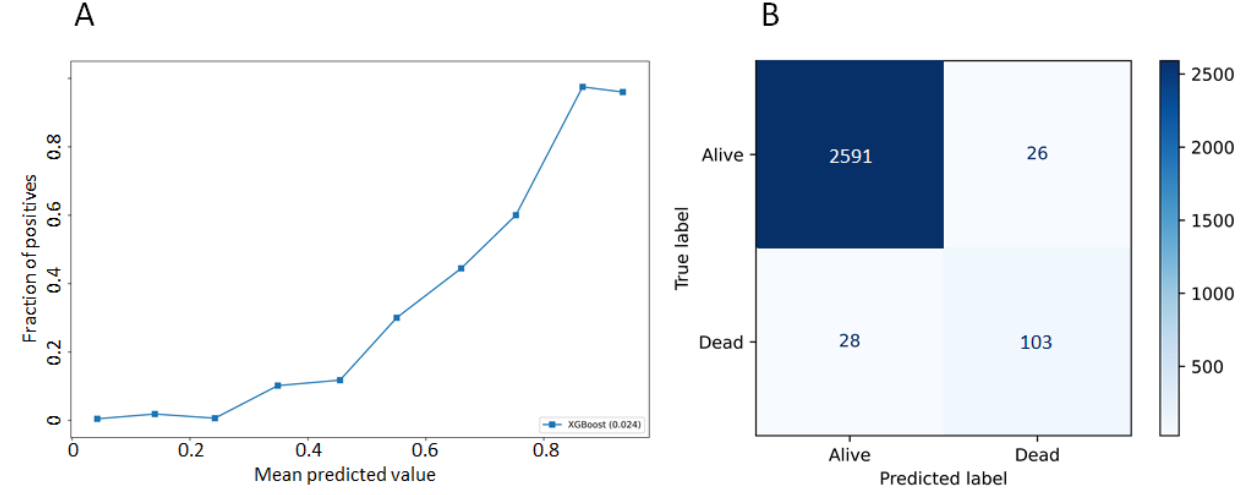
Figure 1. Calibration plot ( A ) and confusion matrix ( B ).